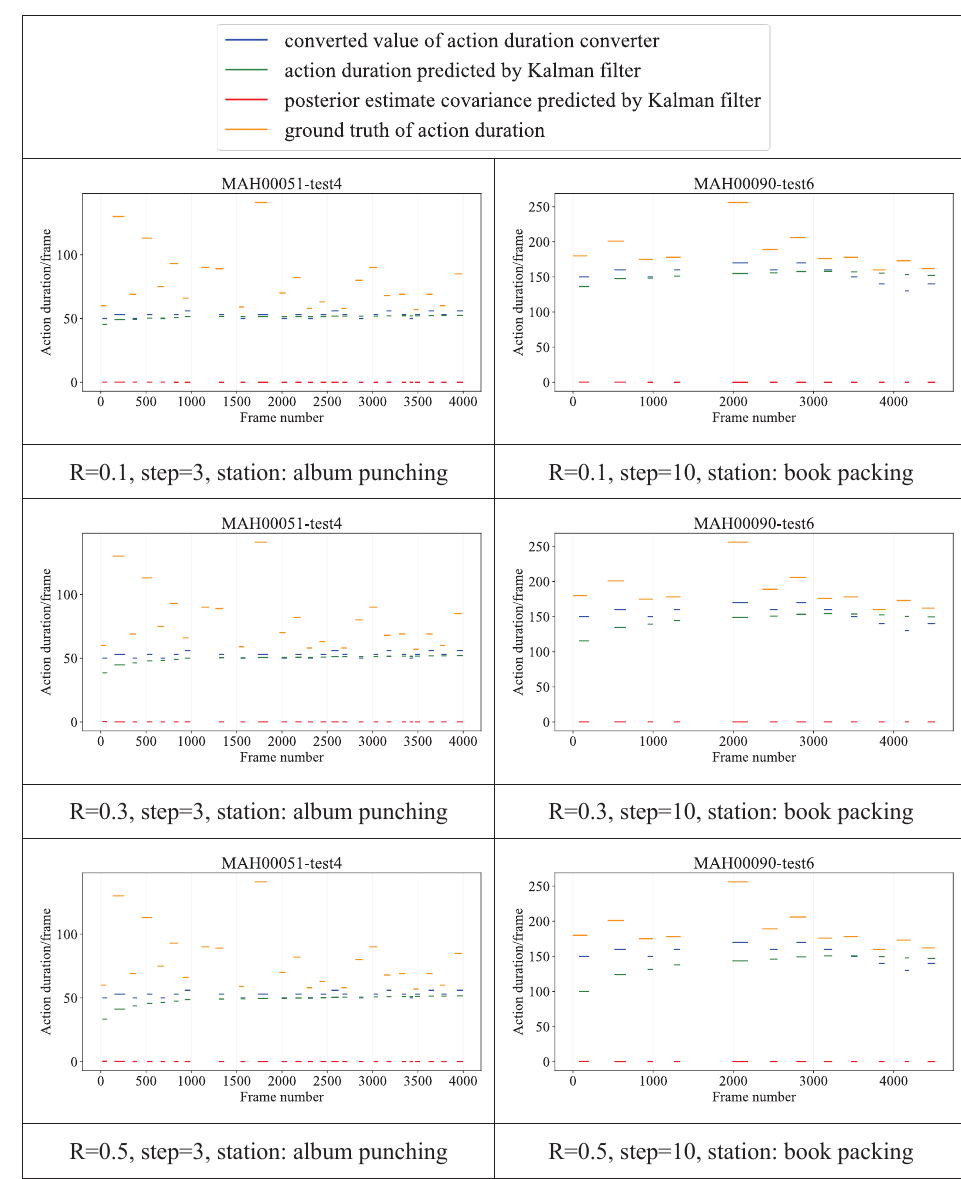
Figure 9. Influence of observation noise R on the results of adaptive parameter